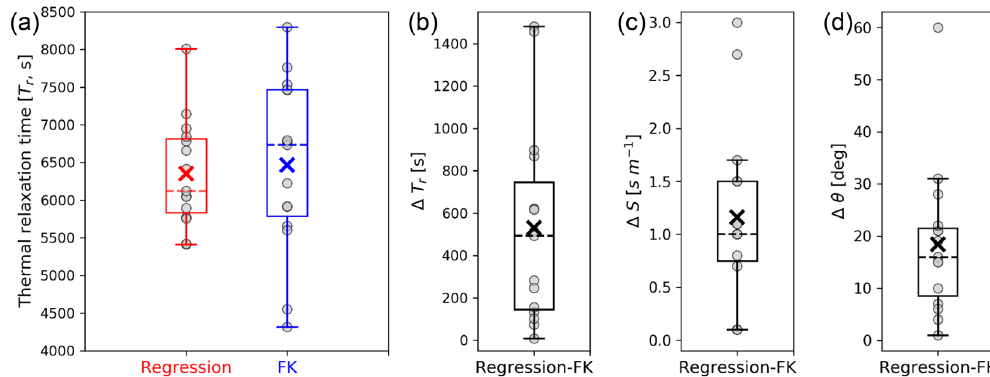
Figure 6. Comparing results from the two different methods for the events in Table S1. ( a ) Statistics of thermal relaxation time (T r ) calculated by regression (red) and frequency-wavenumber ‘FK’ (blue) analyses. ( b ) Thermal relaxation time, ( c ) slowness (S), and ( d ) BAZ (θ) difference between estimation from regression and FK analysis in every event. Gray dots show data from the 15 events. The lower and upper lines on the sides of each box show the 25th percentile (Q1) and the 75th percentile (Q3) of the data, respectively. Median and mean values are shown with a dashed line and cross, respectively. The range between the bottom and top lines is within one and a half interquartile of Q1 and